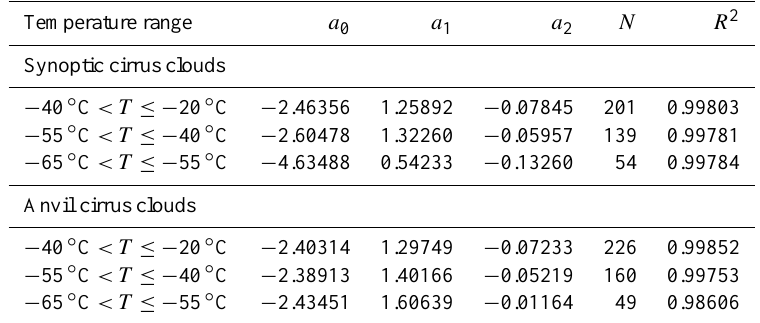
Table 2. Polynomial curve fits of the form ln A = a 0 + a 1 ln D + a 2 ( ln D) 2 for synoptic and anvil cirrus clouds sampled during SPARTICUS, where A is in cm 2 and D is in cm. The number of A - D samples is given by N , along with the coefficient of determination ( R 2 ) of the curve